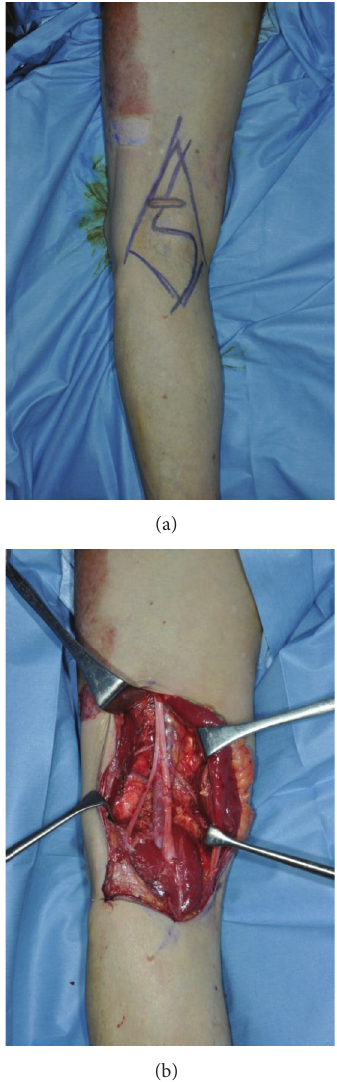
Figure 3: (a) The operative findings of radical popliteal lymph node dissection. A fat pad and lymphatic tissue under the popliteal fascia were dissected from around the popliteal vessels and major nerve trunkstothelowerlegwithanS-shapedincision.(b)Poplitealartery and vein and tibial, common peroneal, and medial sural cutaneous nerves were preserved, although the lesser saphenous vein was sacrificed.